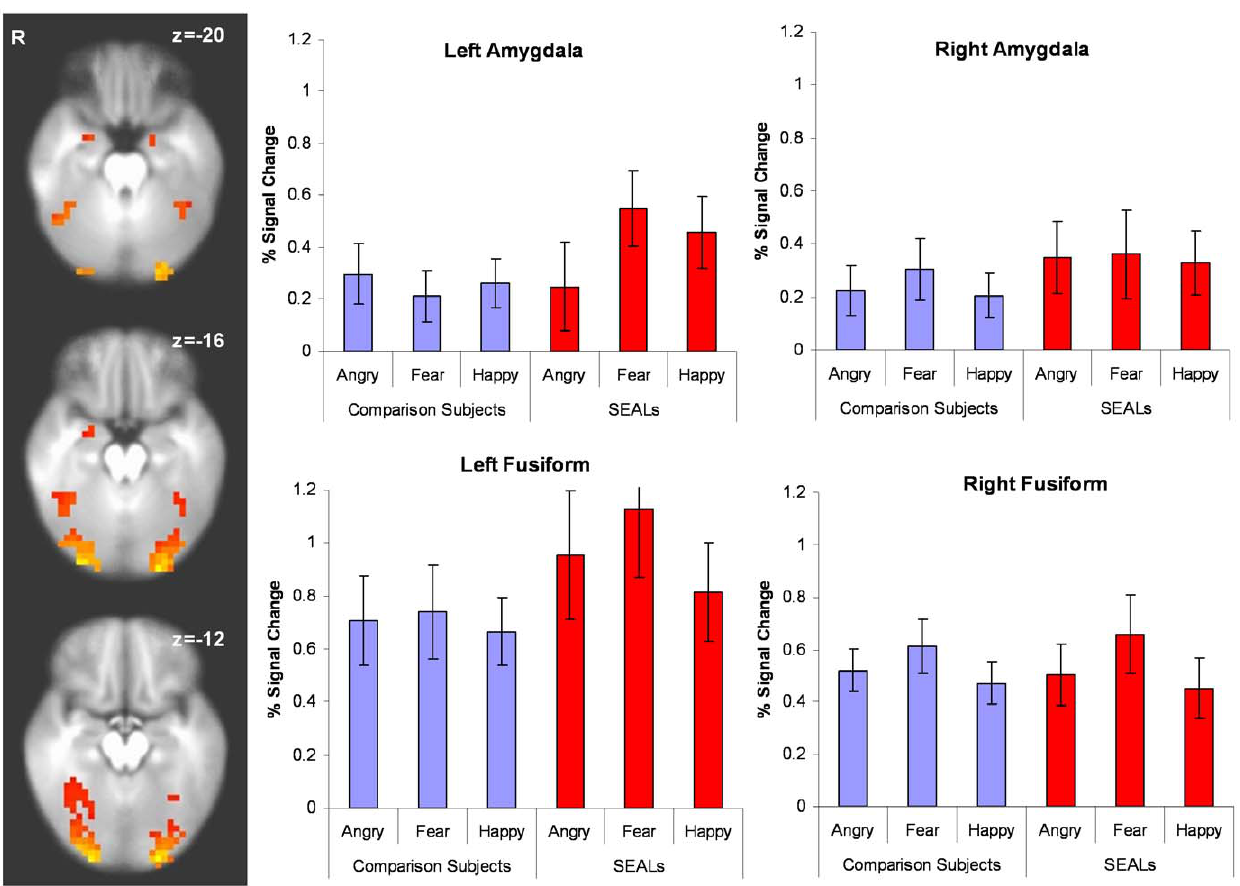
Figure 2. Task-related Activation Task-related brain activation in bilateral amygdala and fusiform gyrus showed no significant group differences.